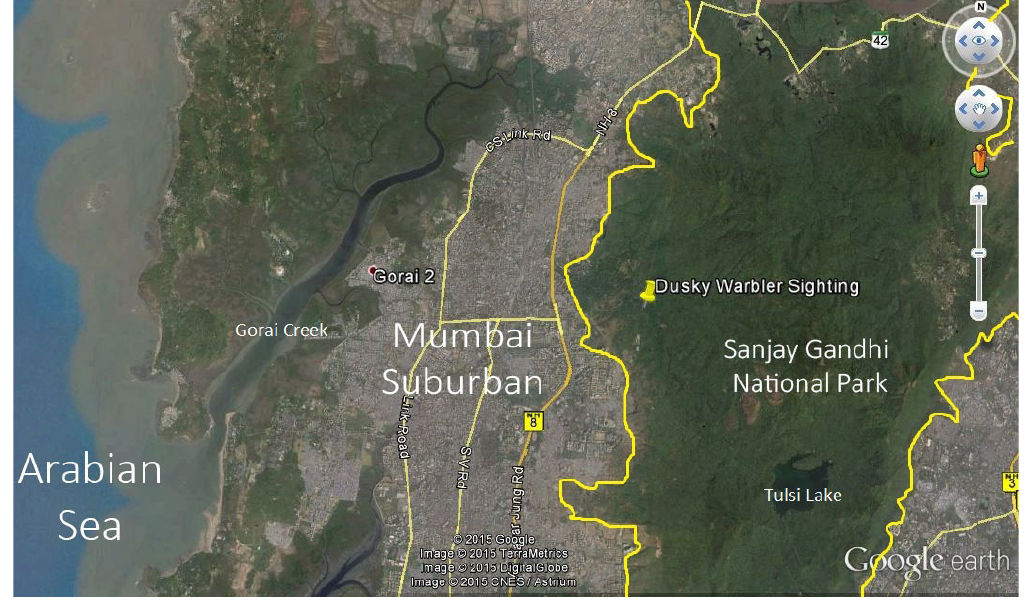
Figure 1. Map of the Sanjay Gandhi National Park, Mumbai, India showing the sighting location of Dusky Warbler Phylloscopus fuscatus .